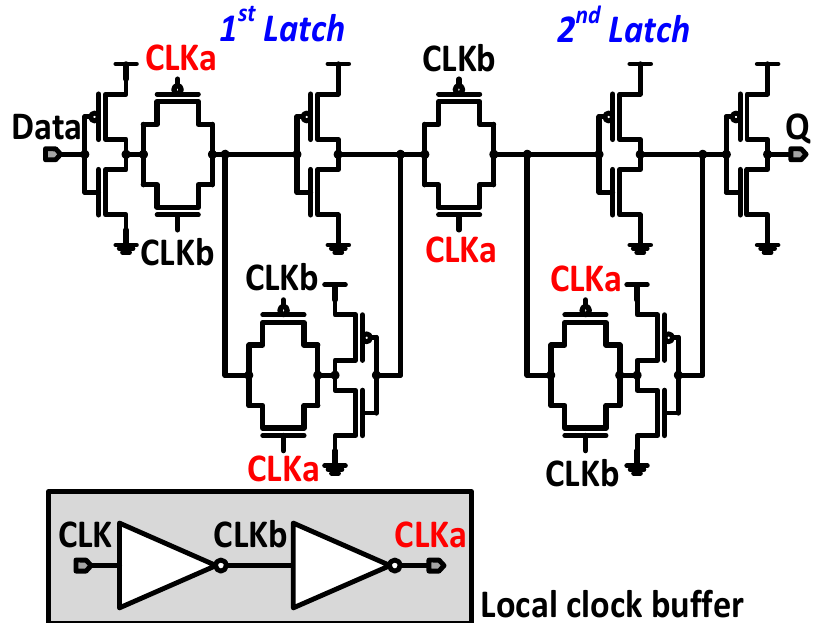
Figure 1. Transmission Gate Flip-Flop (TGFF).